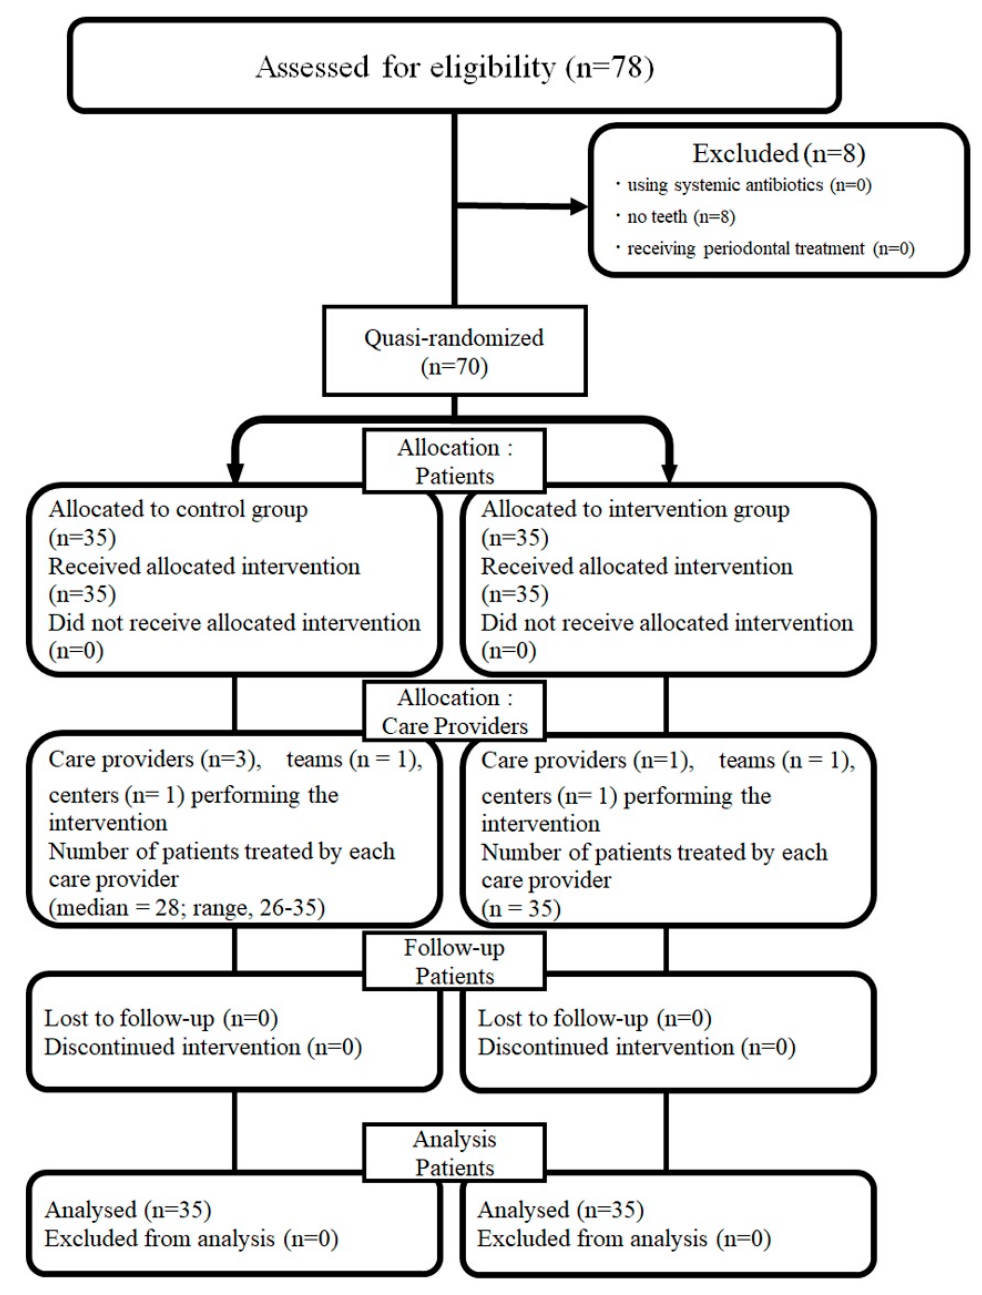
Figure 1. Flowchart of the study.